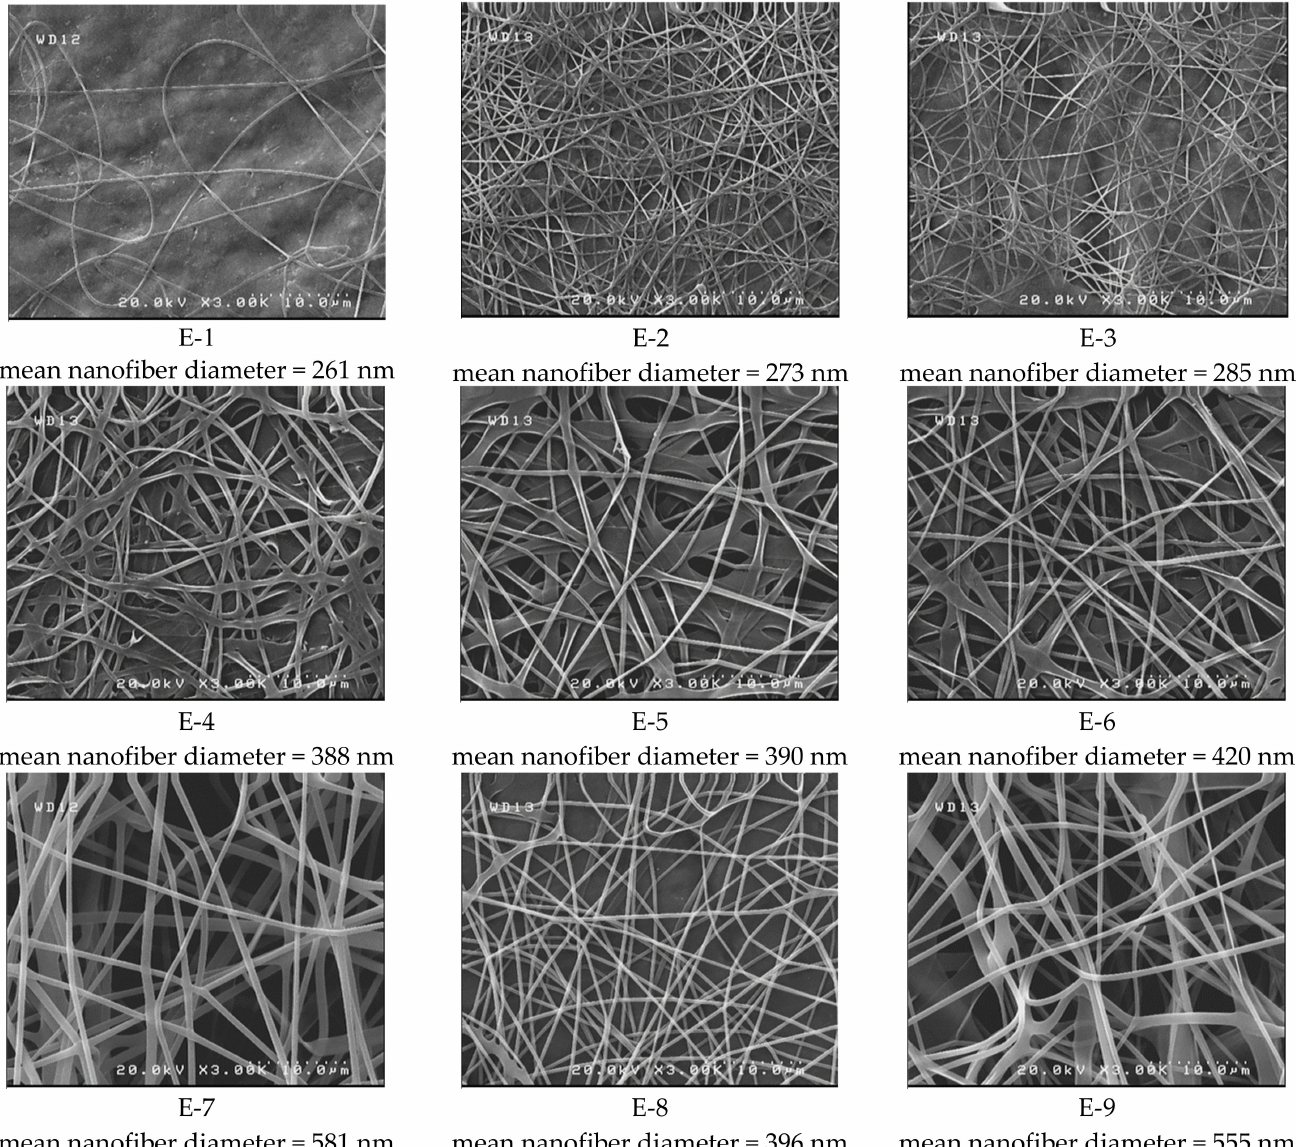
Figure 2. FEEM images of PAAc nanofibers related to experiments 1–9 of the Taguchi